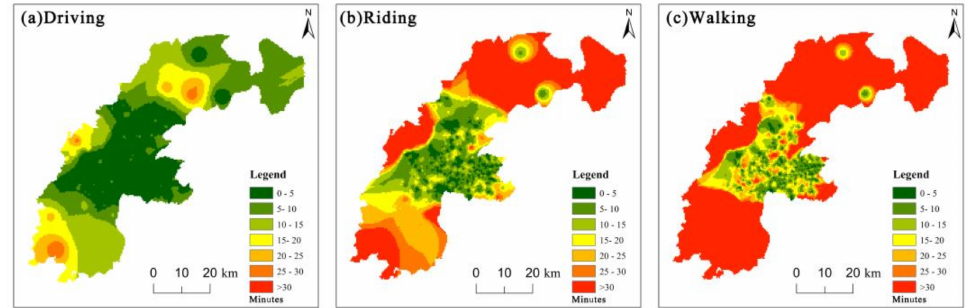
Figure 14. The map of accessibility after the epidemic: ( a ) driving; ( b ) riding; ( c )